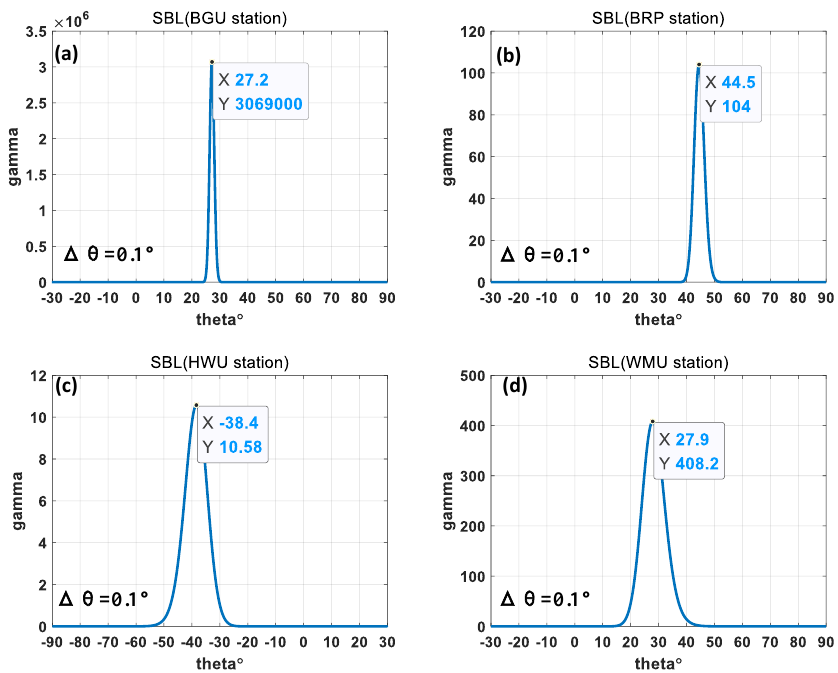
Figure 9. The results of the SBL algorithm for four infrasound stations (the angular resolution ∆ θ is 0.1°): ( a ) the SBL algorithm arrival azimuth estimation result for the BGU station is 27.2°; ( b ) the SBL algorithm arrival azimuth estimation result for the BRP station is 44.5°; ( c ) the SBL algorithm arrival azimuth estimation result for the HWU station is − 38.4°; and ( d ) the SBL algorithm arrival azimuth